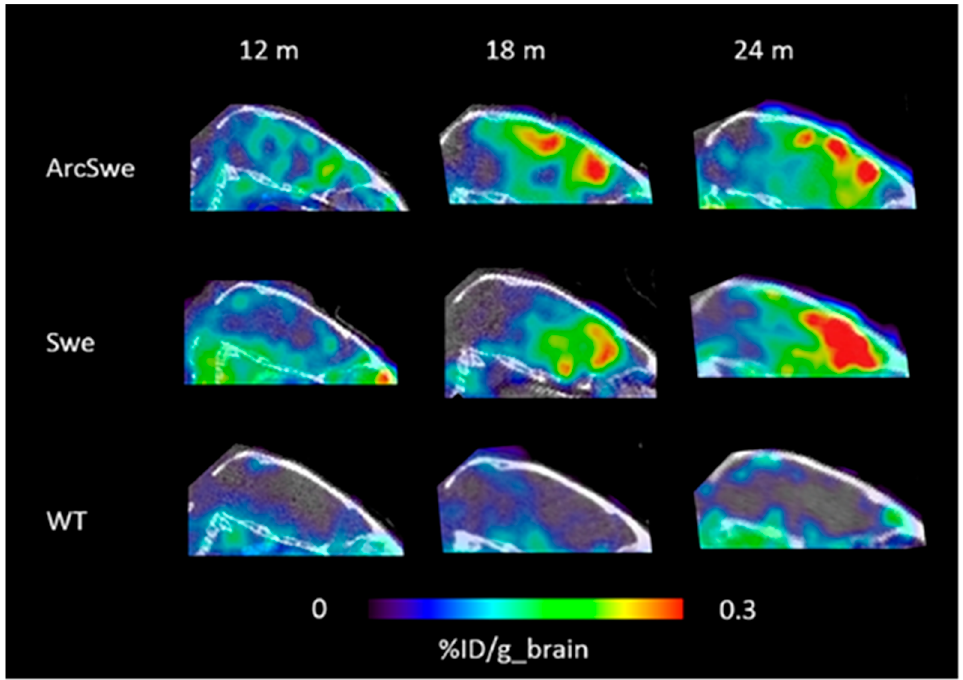
Figure 3. Sagittal PET images obtained at 3 days after administration of the bispecific antibody radiolabeled with I-124 in two transgenic mouse models of AD (ArcSwe and Swe) and wild-type (WT) mice at different ages (12, 18, and 24 months). Quantification of the radiolabeled antibody in brain tissue showed an increasing signal intensity with age (i.e., with increasing A β pathology) in the two transgenic AD animal models, while brains of WT mice were devoid of signal regardless of age. This figure is reproduced from Sehlin and Syvänen (2019) with permission of the copyright owner